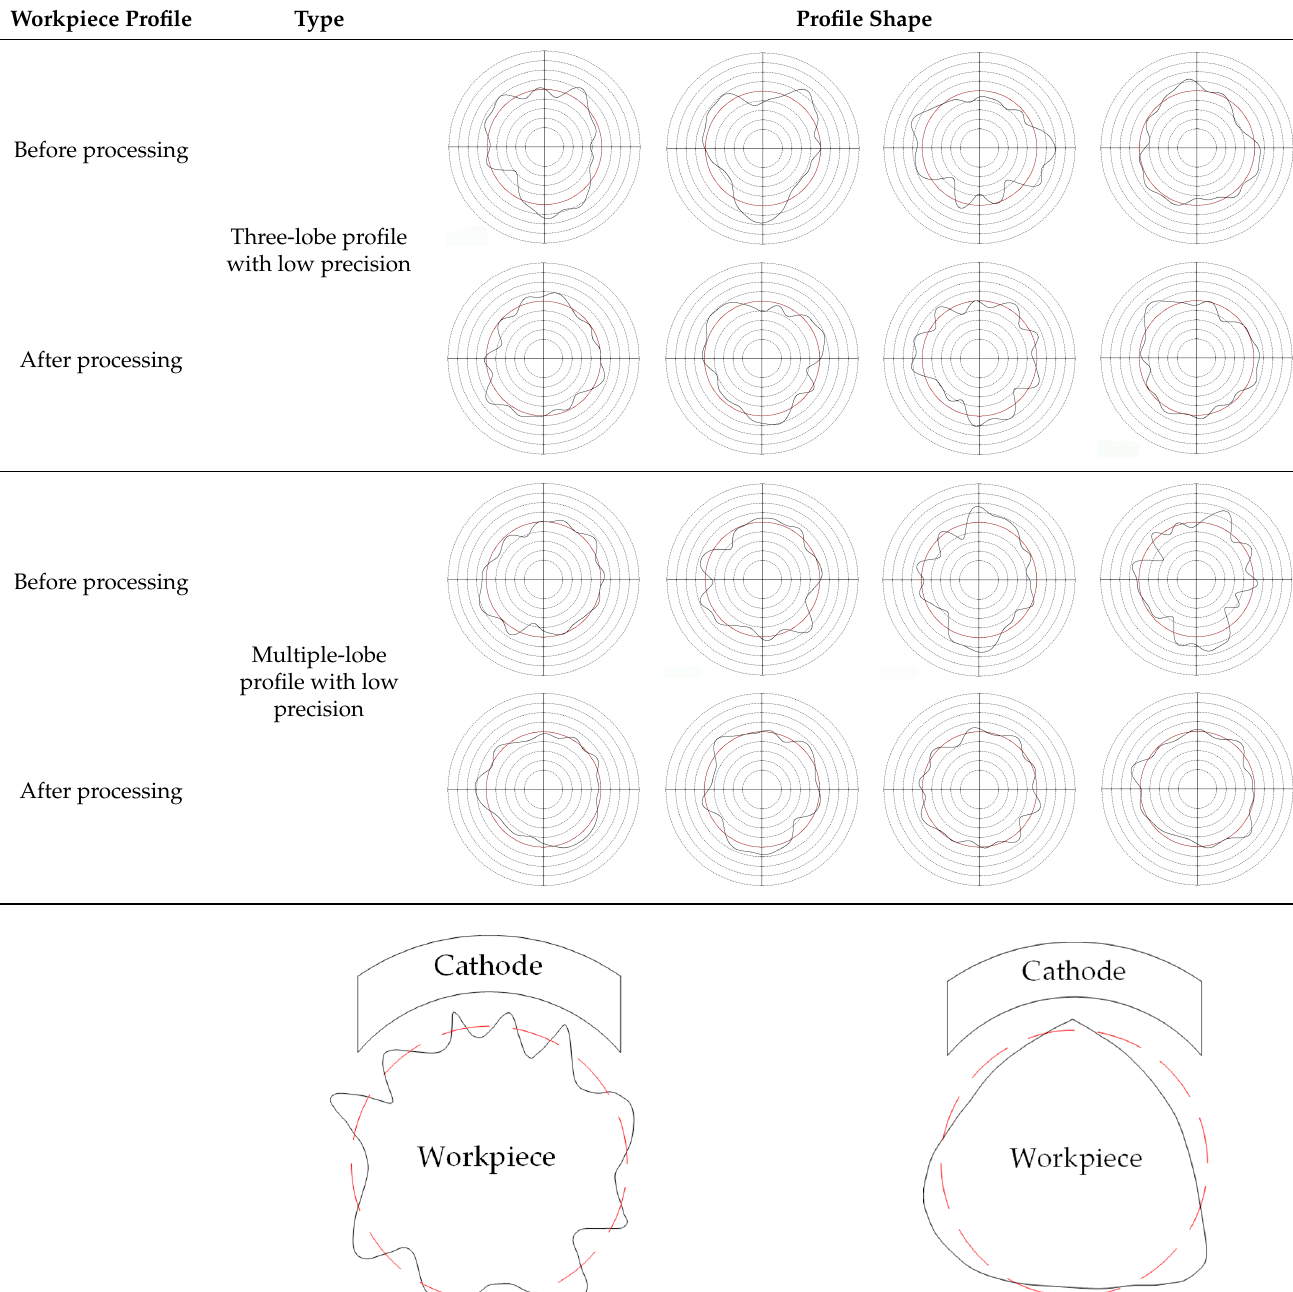
Table 13. Profile shape before and after processing under 90° cathode coverage.